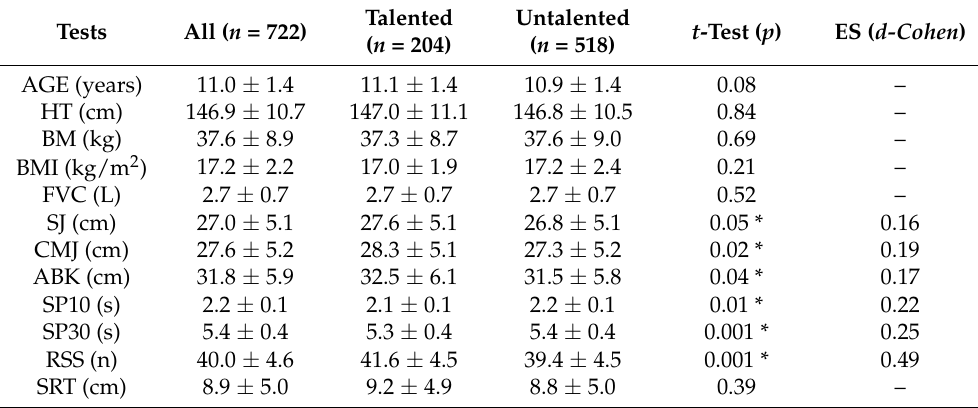
Table 2. Descriptive results and comparison between anthropometric and physical fitness tests for 722 talented and untalented Chinese children soccer